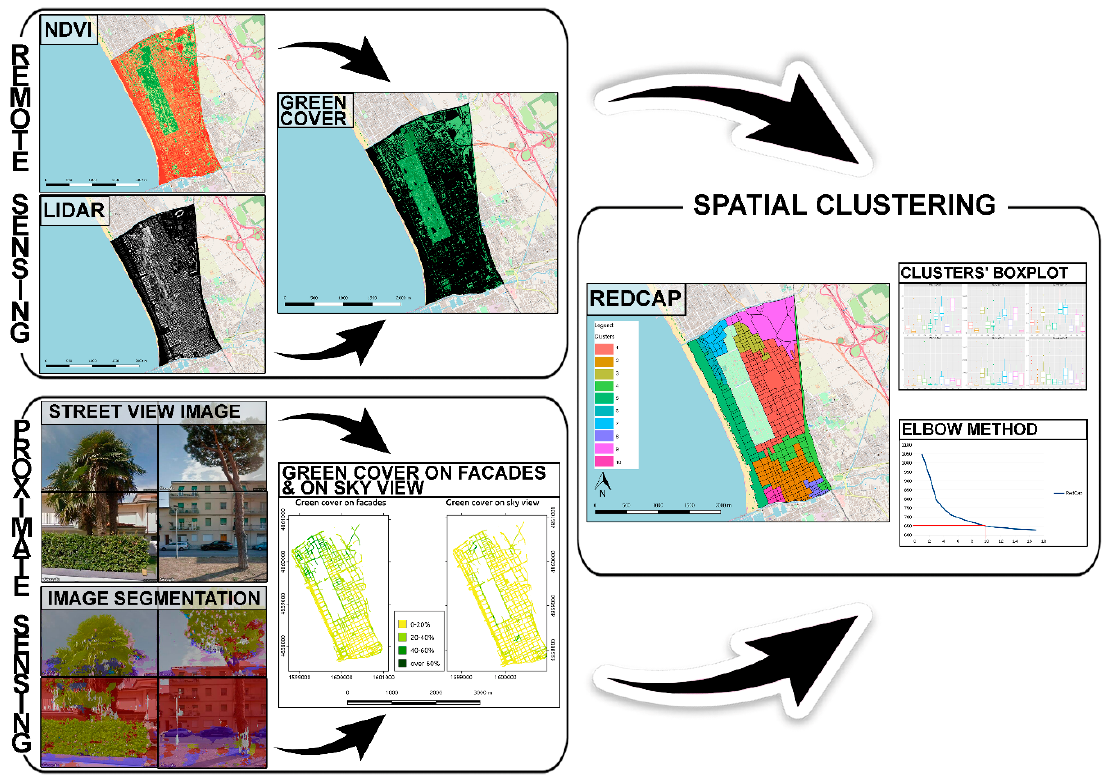
Figure 1. Workflow Figure 1. Workflow diagram.